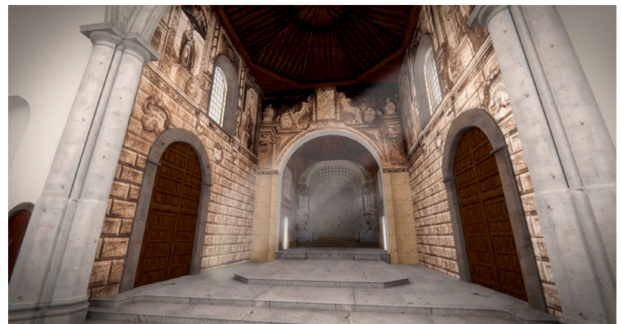
Figure 14. Results of virtual reconstruction: rendering of altar formally displaying its mural paintings. Source: Cor-Ignis